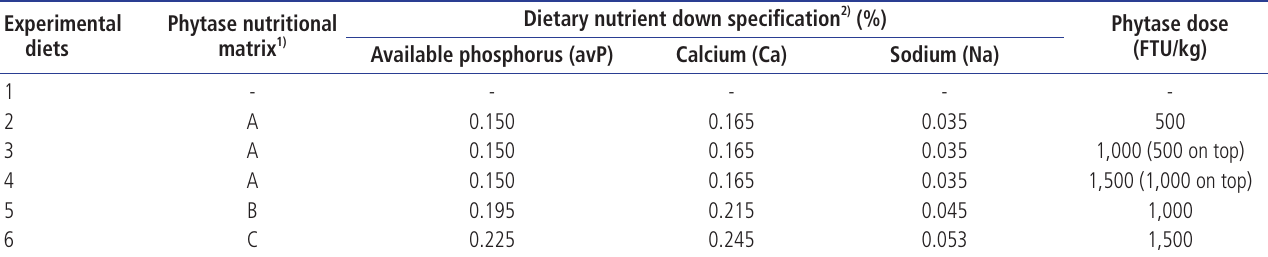
Dietary nutrient down specification 2)